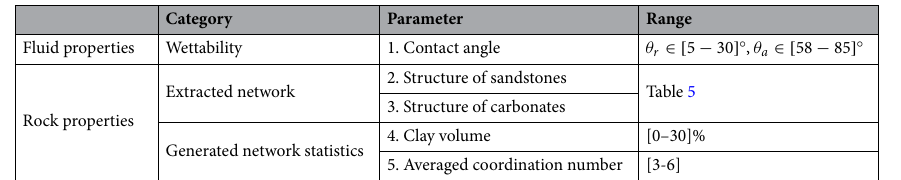
3. Structure of carbonates